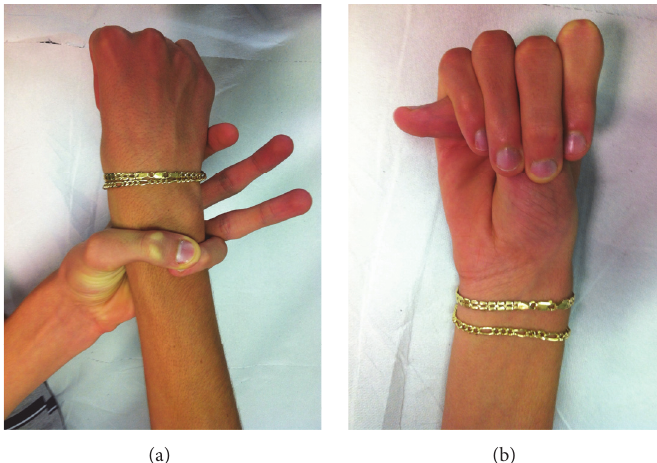
Figure 1: A twenty-year-old female affected by Marfan syndrome with an associated wrist and thumb sign. The “wrist sign” is positive when the thumb overlaps the fifth finger when grasping the contralateral wrist. The “thumb sign” is positive when the thumb extends well beyond the ulnar border of the hand when overlapped by the fingers.